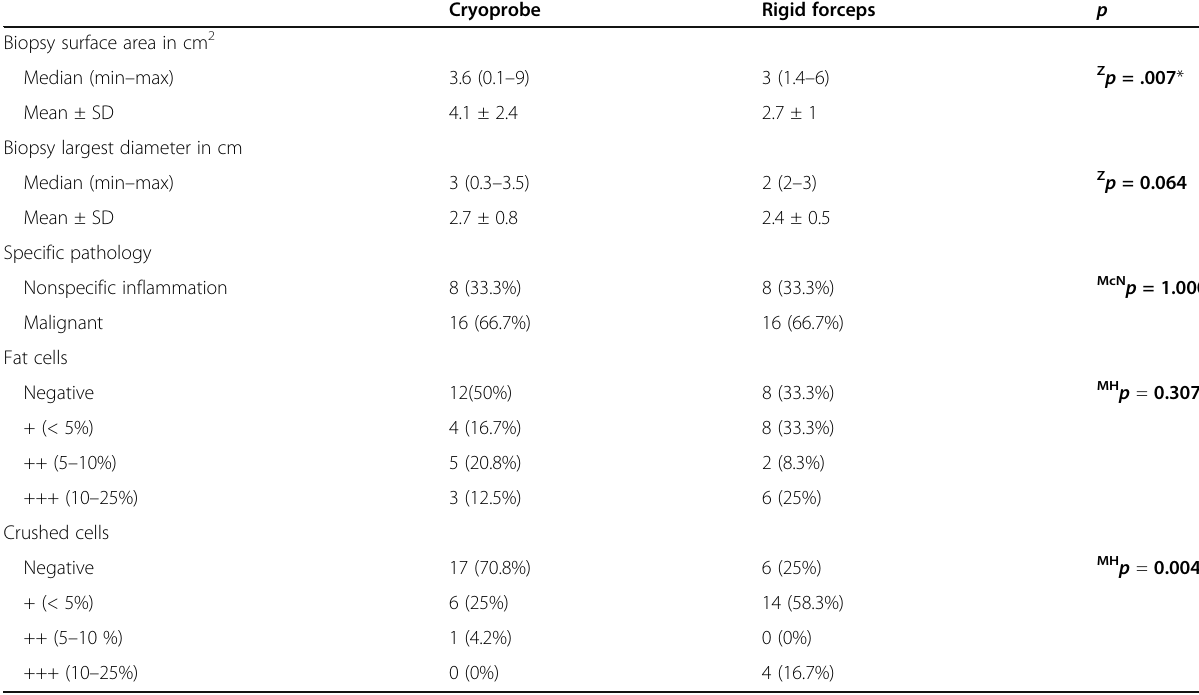
Table 3 Comparison between cryoprobe and rigid forceps according to different parameters ( n = 24)